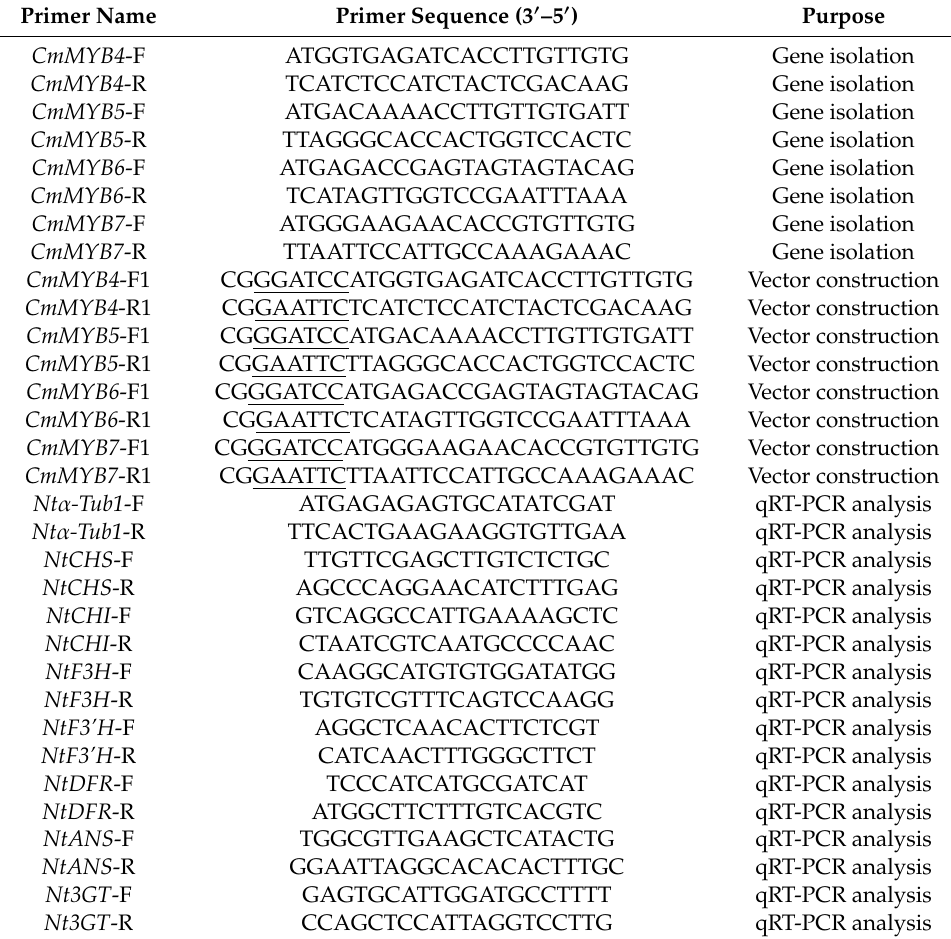
Table 1. List of primers used in the present